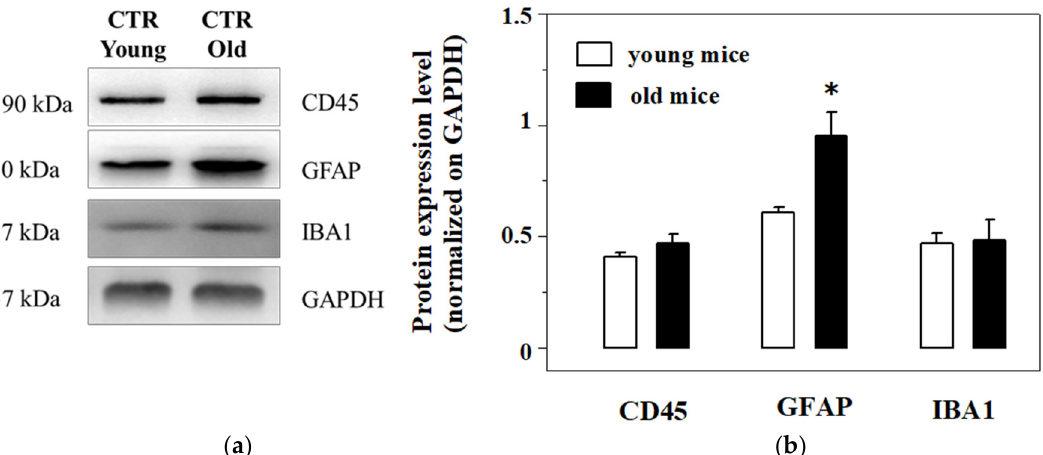
Figure 5. Western Blot analysis and quantification of the expression of the CD45, the glial fibrillar astrocytic protein (GFAP) and Ionized calcium binding adaptor molecule 1 (IBA-1) in cortical lysates from young and old mice. ( a ): representative blots of the GFAP, IBA-1 and CD45 immunostaining in cortical lysates from EAm-untreated young (empty bar) and old (gray bar) mice. The GAPDH protein was used as internal control. The blot is representative of five blots analyzing the lysates from 7 young and 6 old mice that were carried out on di ff erent days. ( b ): quantification of the change in CD45, GFAP and IBA-1 immunostaining in the cortical lysates from young (empty bar) and old (black bar) mice. Data represent the mean ± S.E.M. Results are expressed as mean of the respective protein ÷ GAPDH ratio for the di ff erent animal groups. Statistical analysis was performed by applying ANOVA followed by Student t test analysis for direct comparison * p < 0.05 vs. respective control.